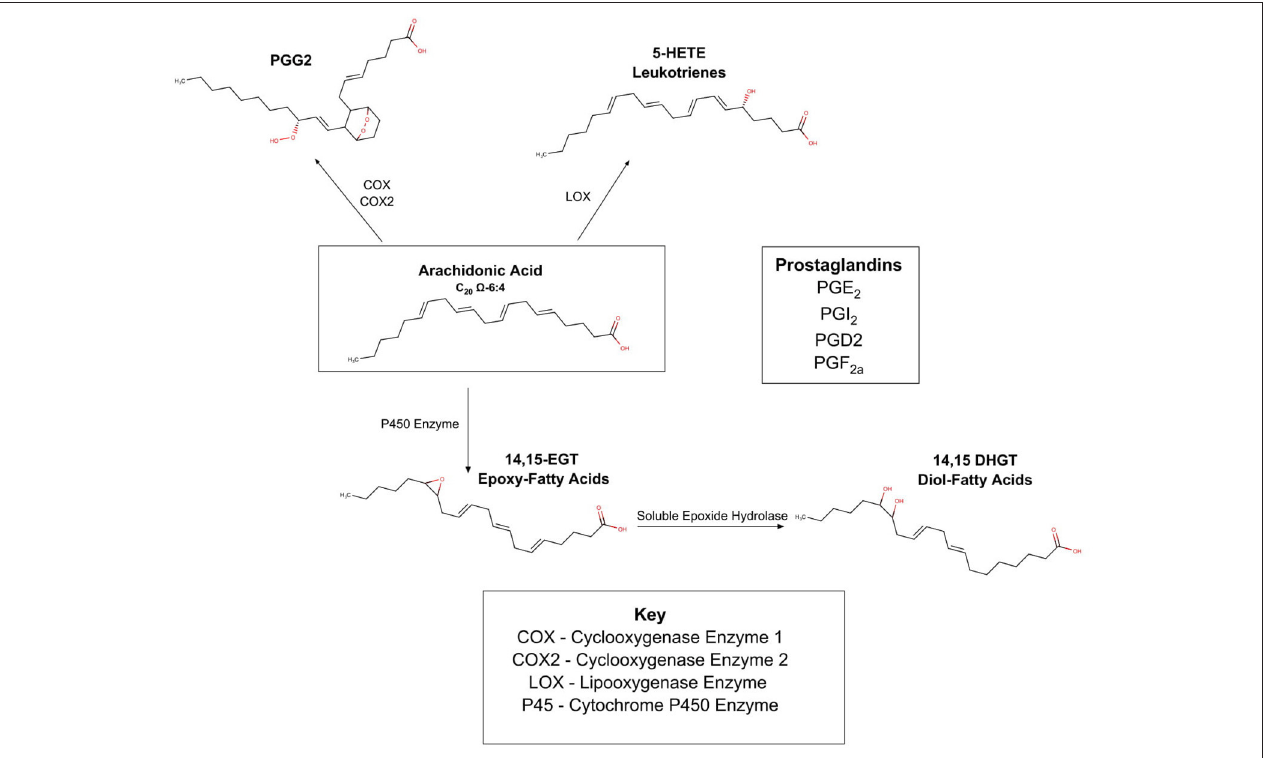
FIGURE 3 | Oxidation of PUFA’s by COX, LOX,